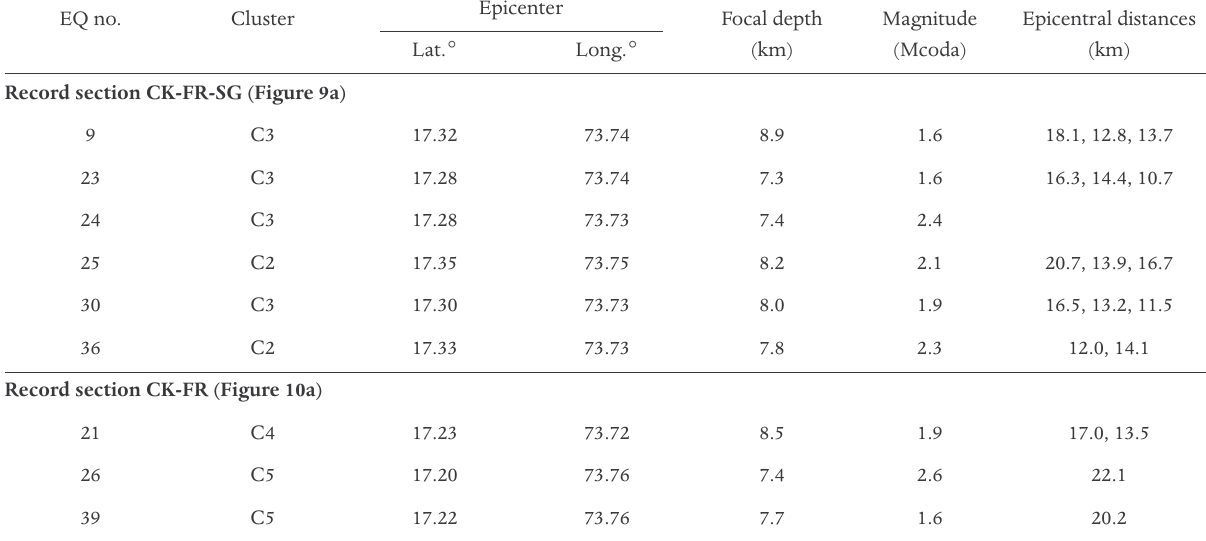
Table 1. Koyna (clusters C2, C3) and Warna (clusters C4, C5) earthquakes (EQ) data for the seismogram sections CK-FR-SG, CK-FR, for an average source depth of 8 km.